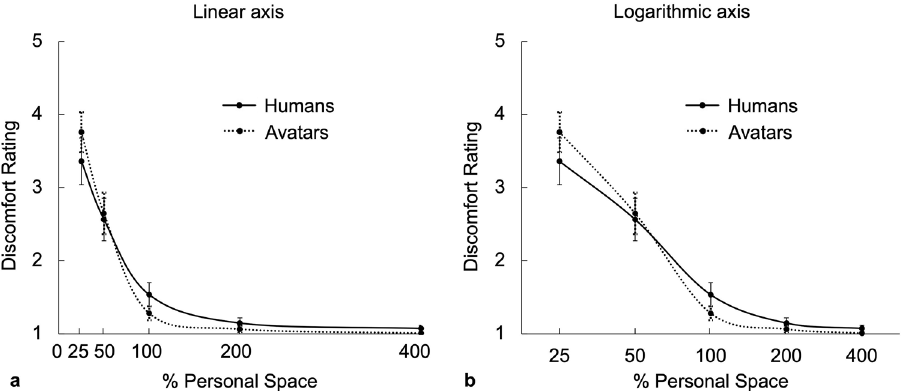
Figure 5. Discomfort ratings across a range of distances, normalized to individual personal space size. Group- average (n = 19) ratings of discomfort (the average of ratings of three statements, see text), on a Likert scale of agreement ranging from 1 (‘not at all’) to 5 (‘very much’), to variations in the distance (as a percentage of the personal space size of each subject) (x axis) in response to humans (solid line) and avatars (dotted line). Discomfort ratings were highest for both humans and avatars presented at the closest distance (25% of personal space size). Conversely, the discomfort ratings were lowest to both humans and avatars (at and near baseline of 1 = lowest possible ratings) when presented at distances further than the personal space boundary, i.e. 200% and 400% of a given subjects’ personal space size.